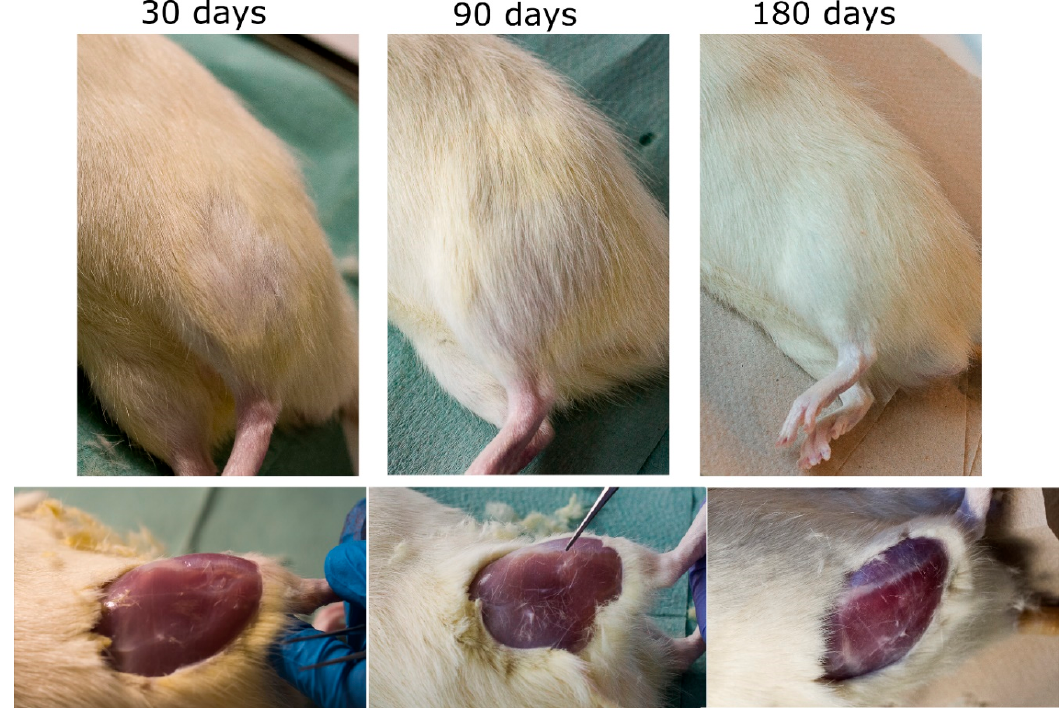
Figure 5. Implantation site after 30 days ( left ), 90 days ( center ) and 180 days for otoimplant/AgNPs.